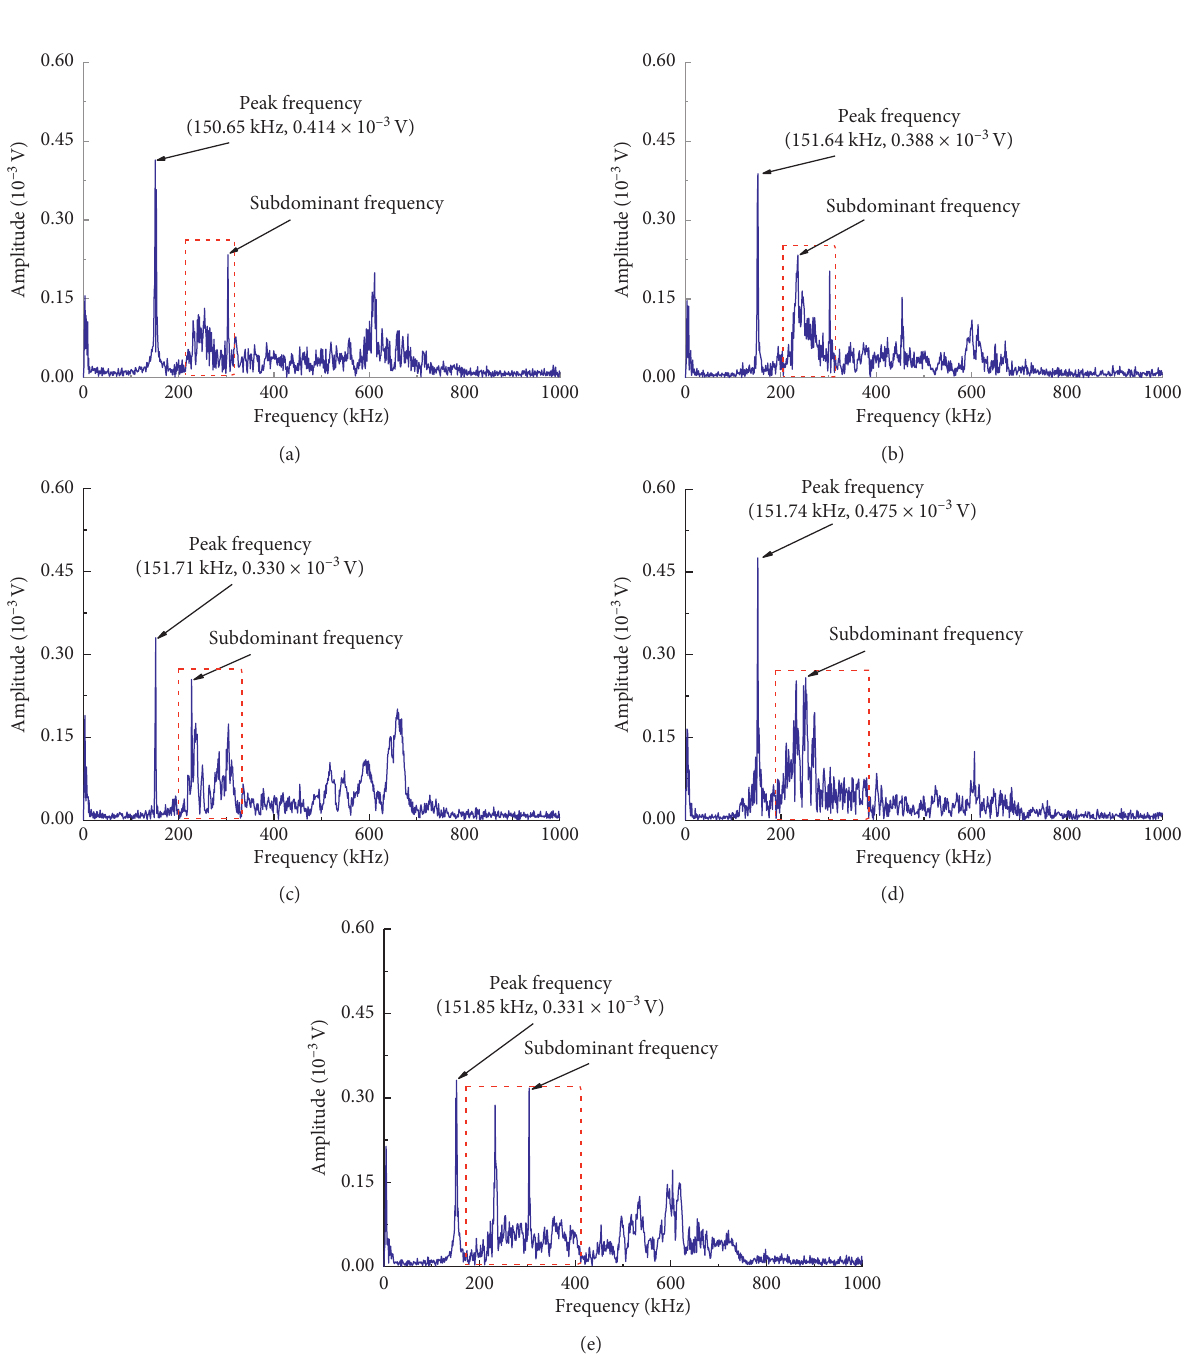
Figure 8: Amplitude and frequency characteristics of coal-like material samples under different borehole arrangements. (a) Scheme I 03: complete samples. (b) Scheme II 02: samples with boreholes. (c) Scheme III 02: samples with borehole with stepwise increased borehole depth. (d) Scheme IV 01: samples with borehole with stepwise increased borehole diameter. (e) Scheme V 03: samples with borehole with stepwise increased borehole depth and borehole